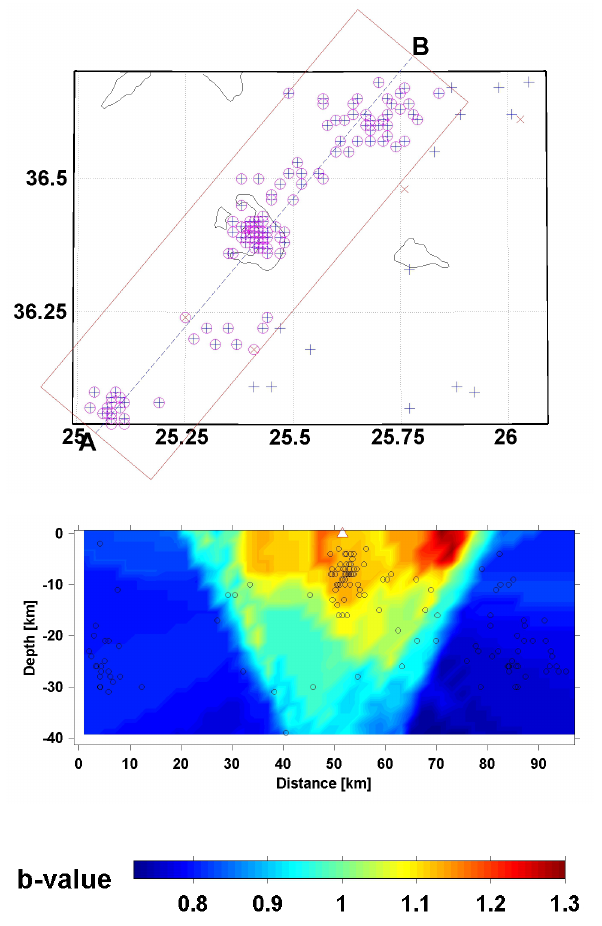
Fig. 9. b-value cross section showing the spatial variation after the detection increases in 2010 and 2011, along a NE-SW profile across the volcanic